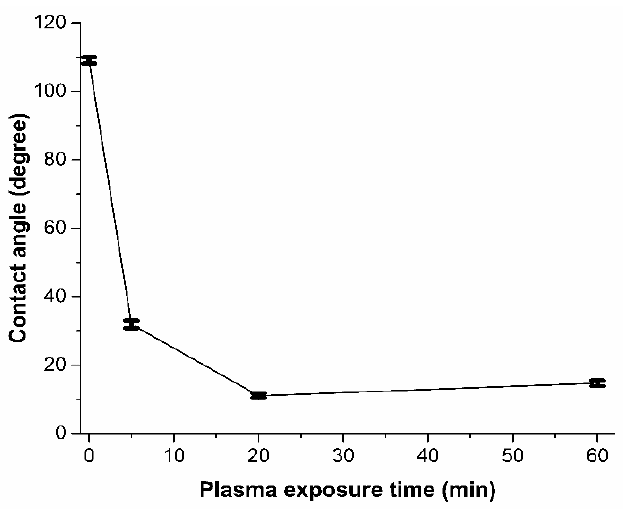
Figure 2. Variation of DI water contact angle with plasma exposure time in plasma treated COC. Each contact angle datapoint shows the average value from ten measurements.